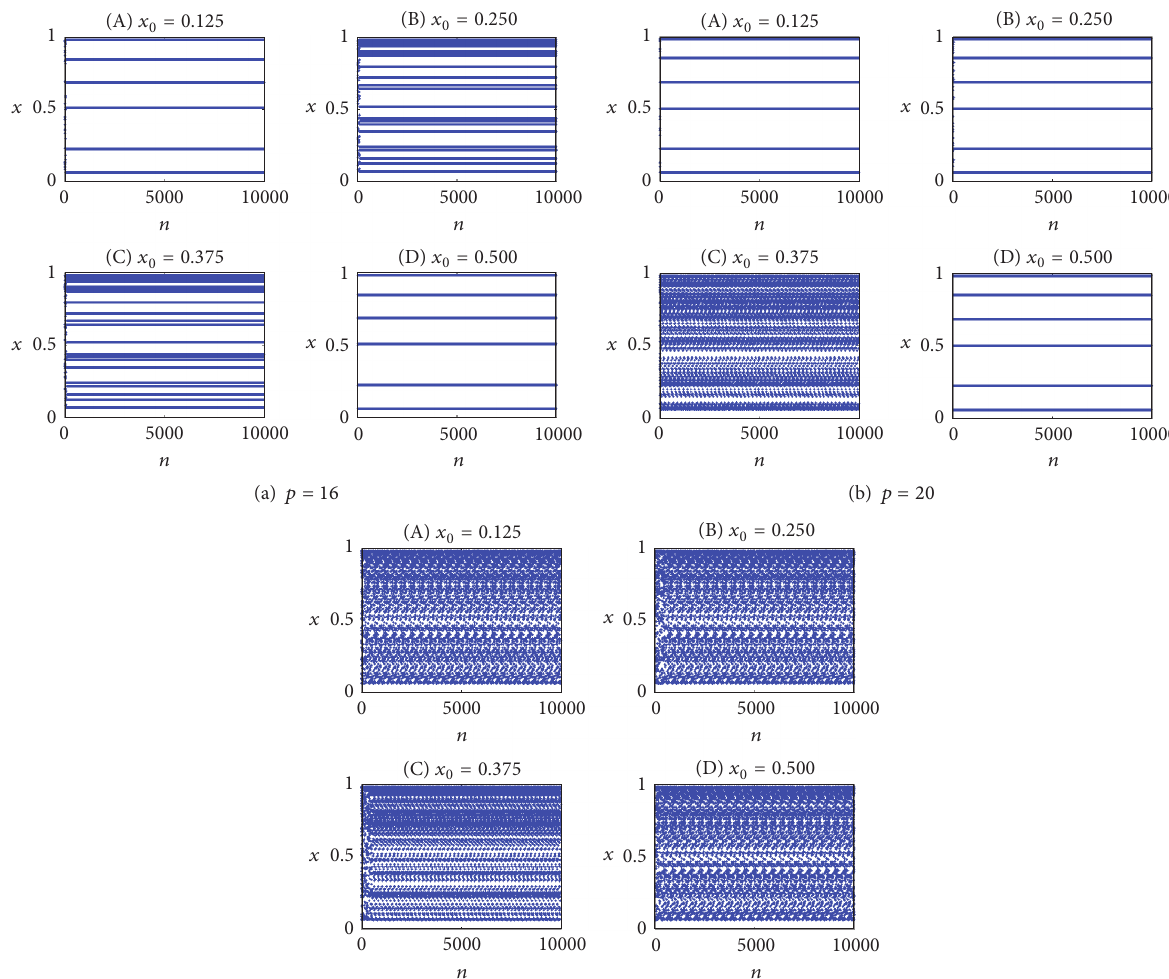
Figure 10: Time series of 𝑓 6 (𝑥) at 𝜆 = 3.9375 starting at different initial conditions and various precisions.